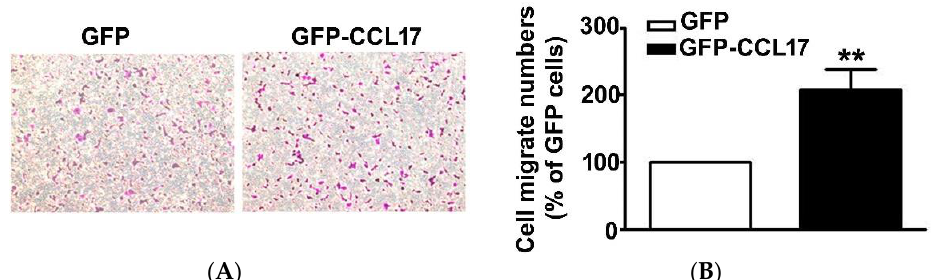
Figure 3. The motility of CCL17-transfected HK2 cells. ( A ) The migration of HK2 cells transfected with GFP- and GFP-CCL17 were determined by using an in vitro migration assay. Cells in the lower surface of the Boyden chamber were stained and photographed under a light microscope at ×400 magnification. ( B )The number of cells that migrated are quantified and shown as a histogram chart in the right panel. Results are expressed as mean ± SD of at least three independent cell experiments. ** p < 0.01 compared with GFP cells.